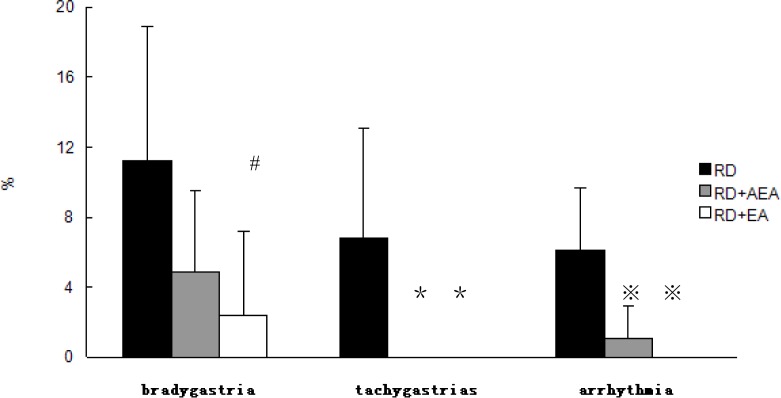
Effects of AEA on RD-induced gastric dysrhythmia.EA reduced the percentage of bradygastria (B%) significantly during RD (#P<0.05, vs. RD). The percentage of tachygastrias (T%) decreased to 0% after using EA and AEA respectively during RD (＊P<0.05, vs. RD). The percentage of arrhythmia (A%) decreased significantly as well after using EA and AEA respectively during RD (※P<0.05, vs. RD).